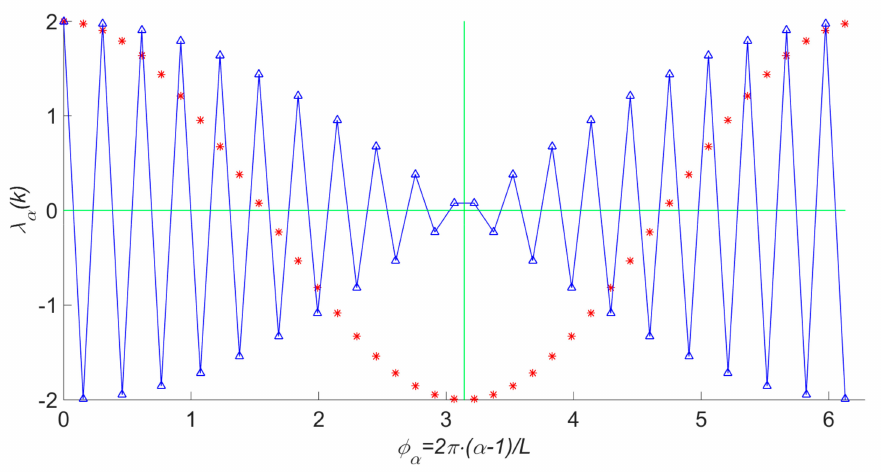
Figure 1. Eigenvalues { λ α ( k ) } , α = 1,2, . . . , L = 41 of matrices J ( k ) when k = 1 ( ∗ ) and k = 20 ( ∆ ) . The vertical line in the middle shows explicitly the mirror symmetry of